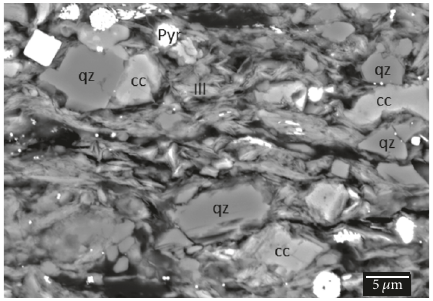
Figure1:Ascanningelectronmicroscopy(SEM)imageshowingthe mineral composition and microstructure of a typical shale sample (courtesy of C. Delle Piane). In this sample, the quartz (qz), calcite (cc), and pyrite (Pyr) grains are randomly distributed while the illite (Ill) shows some local disorder or misalignment, with respect to the vertical symmetry